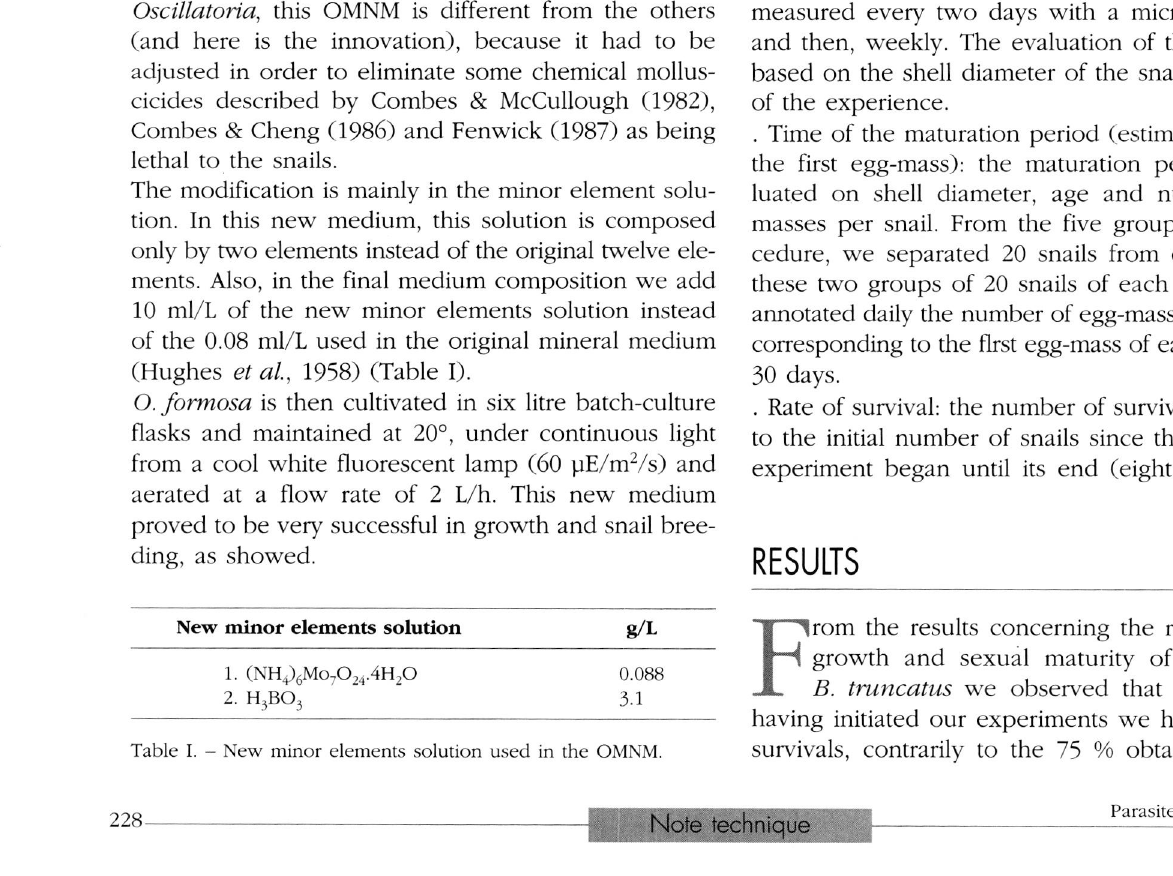
Table I. - New minor elements solution used in the